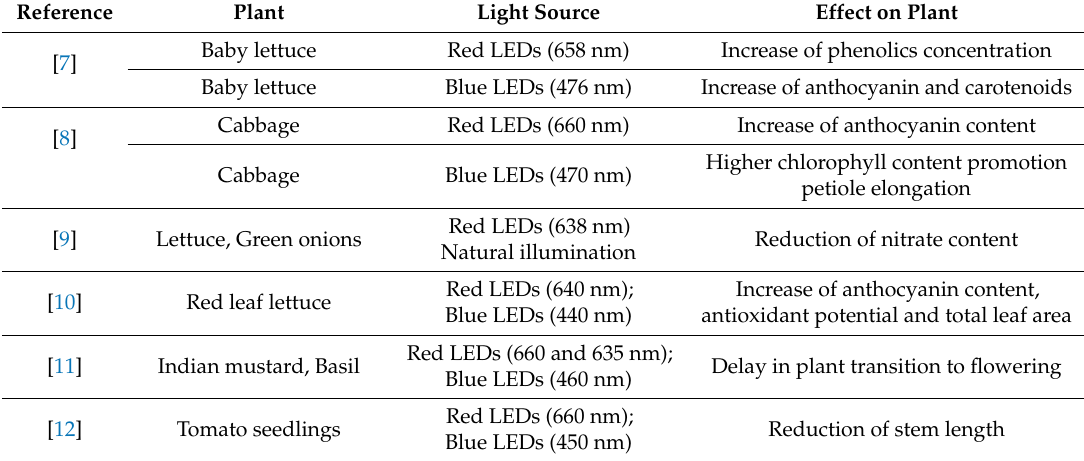
Table 1. Effects of light emitting diode (LEDs) with various wavelengths on the